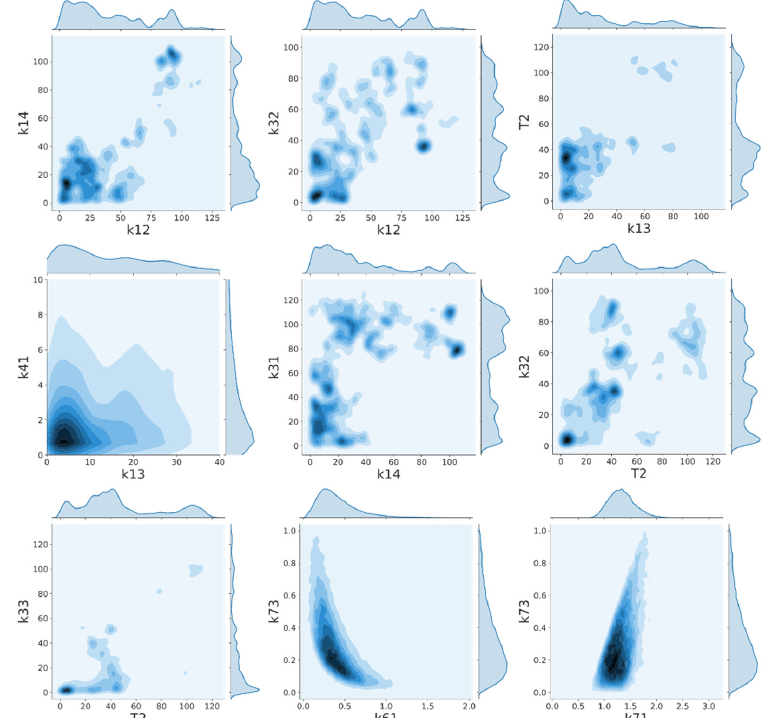
Figure 5. Correlation plots of MCMC parameter exploration. Nine parameter pairs were found to have a Pearson’s Correlation Coefficient > ±0.5. These significant pairs are plotted here.